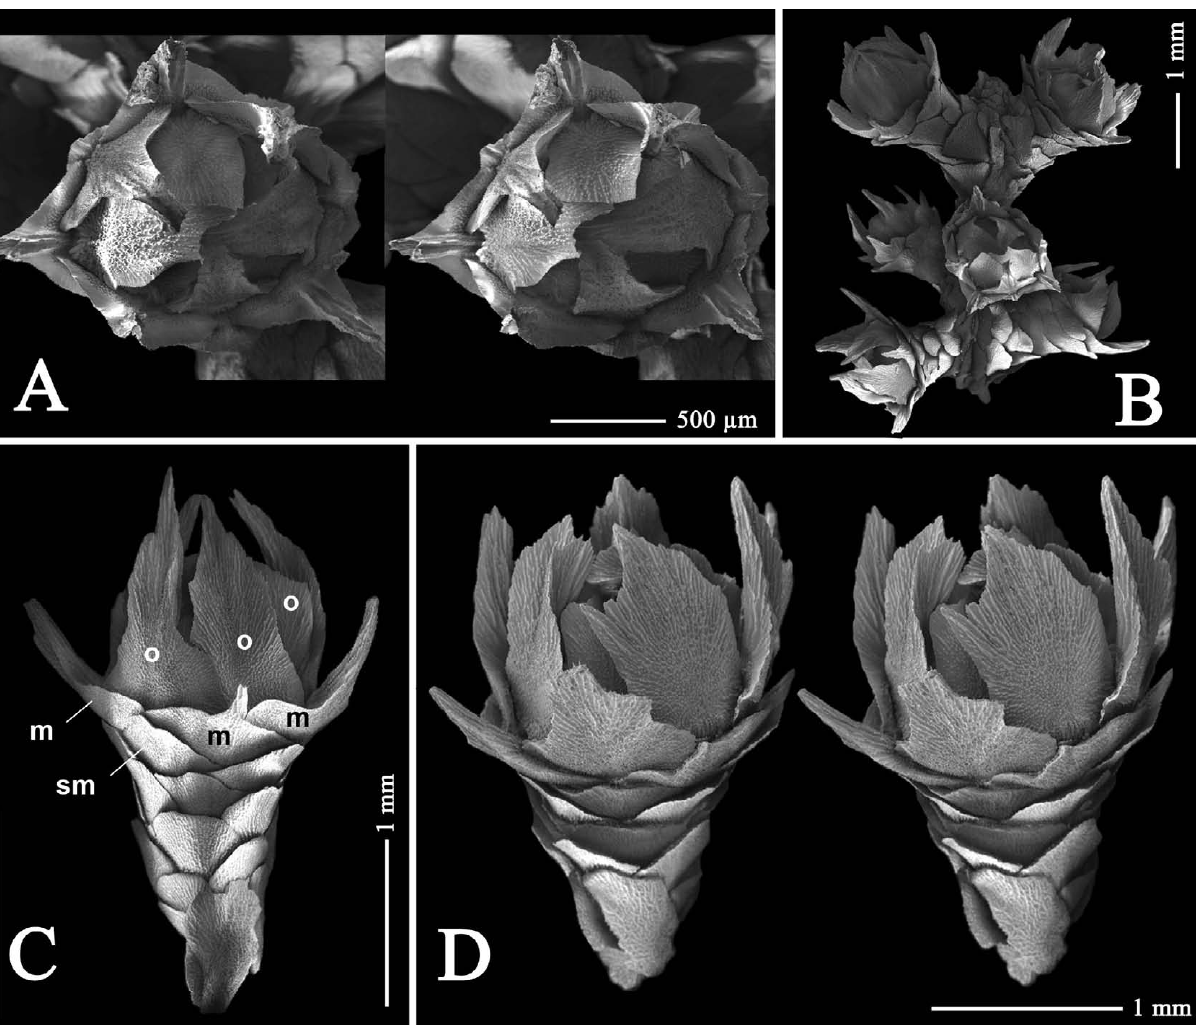
Fig . 11. – Thouarella andeep n. sp., holotype ZiZMH c11744: a, polyps in oral view, stereo pair; b, detail of branchlet; c, polyps in latero- abaxial view; d, polyps in adaxial view, stereo pair. abbreviations: o, opercular scales; m, marginal scales; sm, submarginal